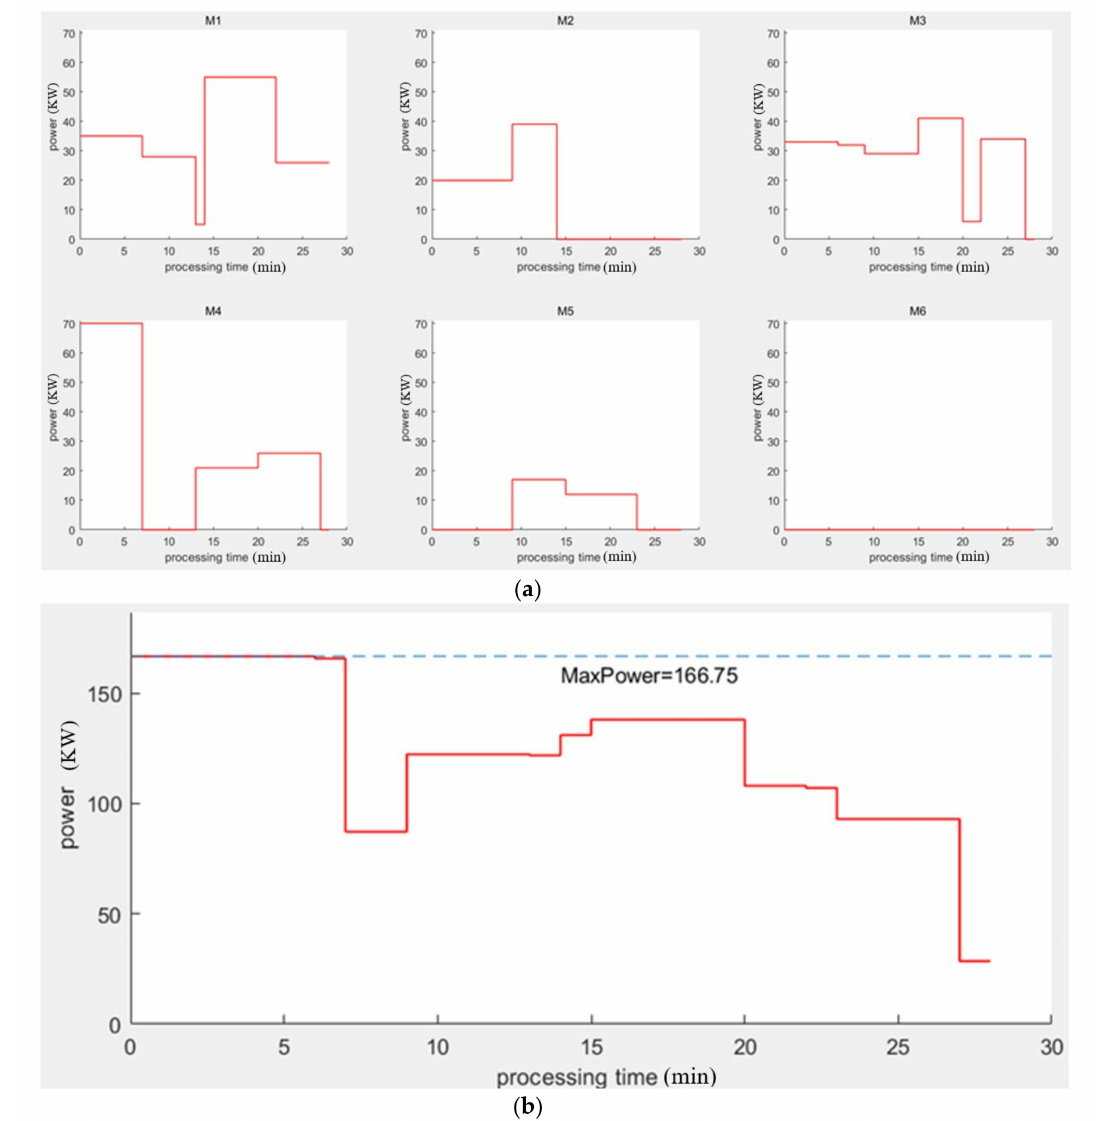
Figure 4. Power curves: ( a ) power curves for each machine; ( b ) total power curve for the job